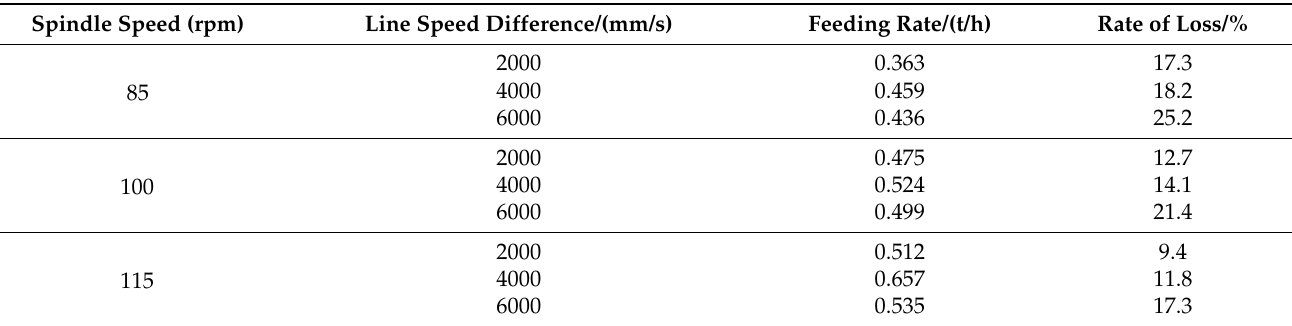
Table 2. Orthogonal simulation test results.